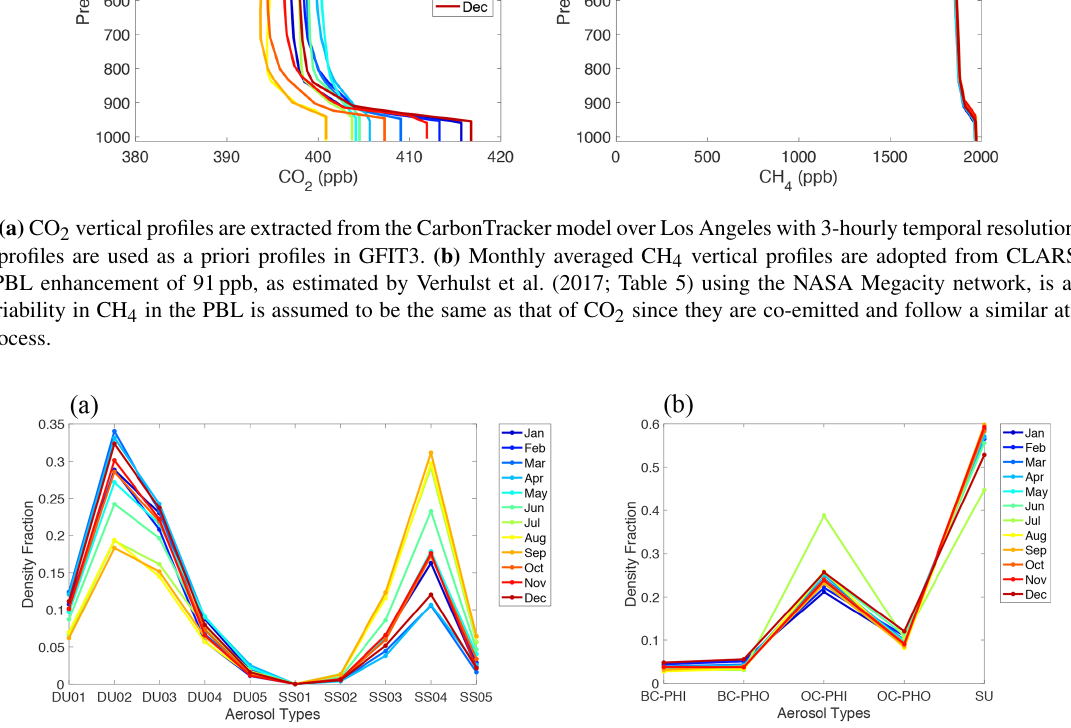
Figure 6. Aerosol composition from Modern-Era Retrospective Analysis for Research and Applications (MERRA) reanalysis data for LA (07:00, 10.00, 13:00, 16:00LT). (a) Monthly averaged density fraction of aerosols for dust and sea salt. The dry size bins for dust (DU01 to DU05) correspond to the radius limits (in microns) 0.1–1, 1–1.8, 1.8–3, 3–6, and 6–10, respectively. Similarly, for sea salt (SS01 to SS05), the corresponding values are 0.03–0.1, 0.1–0.5, 0.5–1.5, 1.5–5, and 5–10, respectively. (b) Monthly averaged density fraction